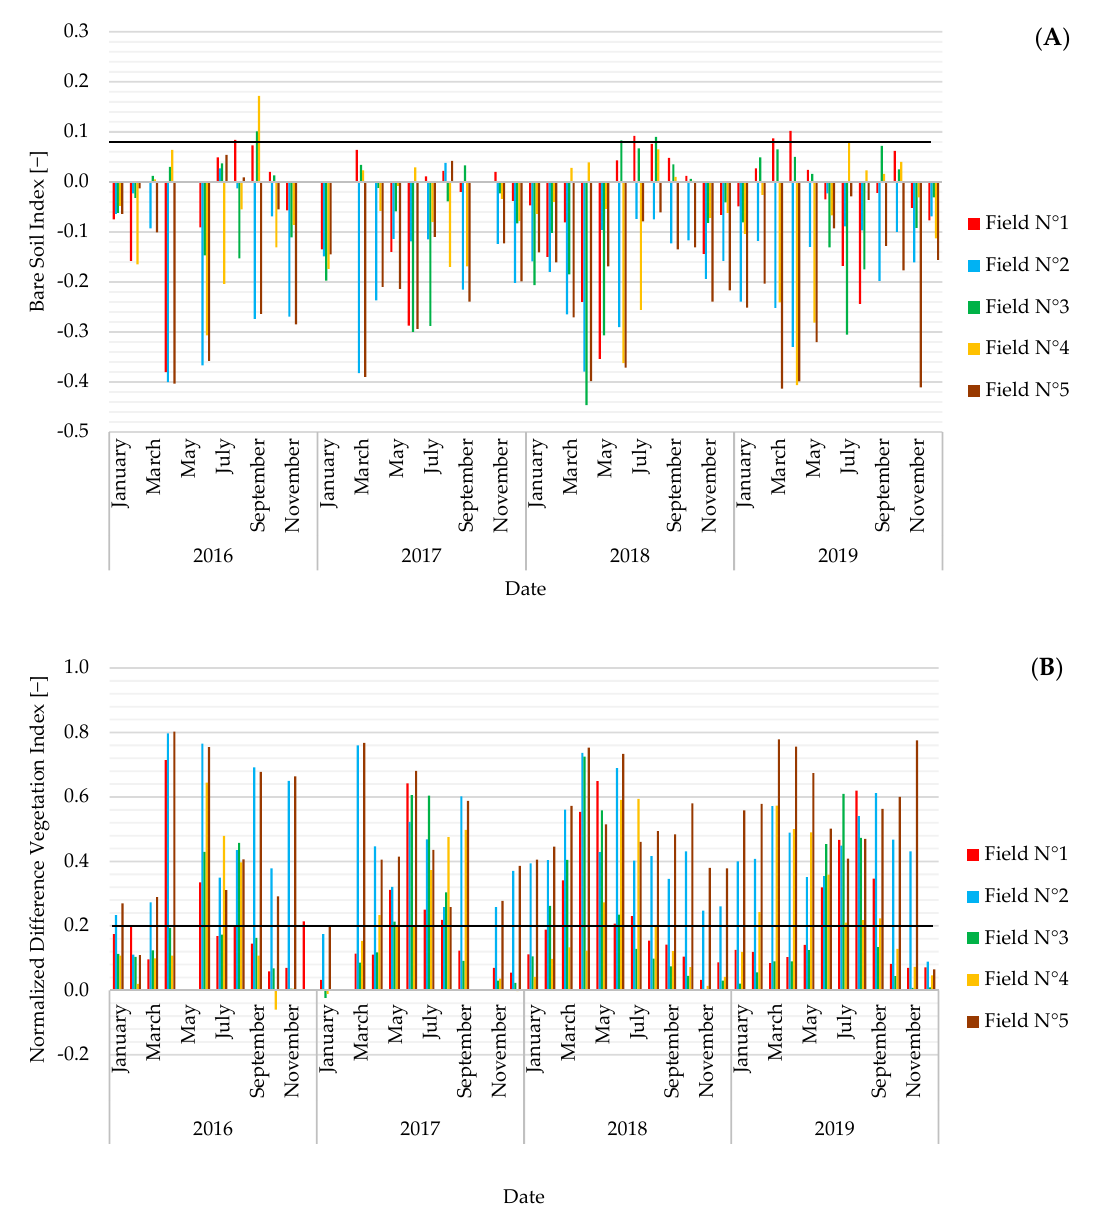
Figure 4. ( A ) Bare Soil Index (BSI) and ( B ) Normalized Difference Vegetation Index values (NDVI) [ − ] for the pixels in the set of selected agricultural fields of the agricultural areas of Ferrara (Northern Italy). The horizontal black lines show the selected thresholds.